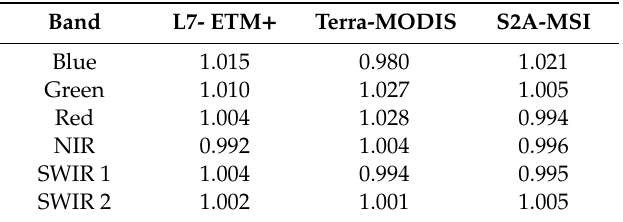
Table 8. Scaling Adjustment Factors for Libya 4 PICS for each Sensor, by Band (Normalized to OLI). Band L7- ETM+ Terra-MODIS S2A-MSI